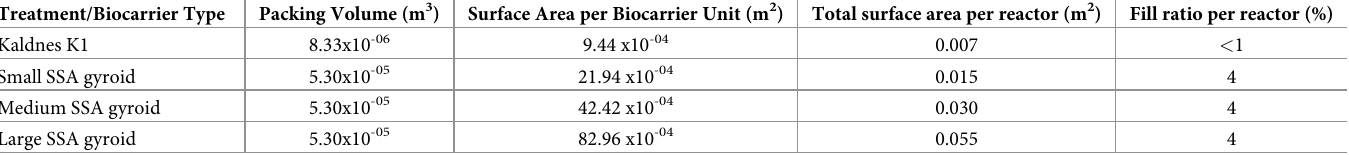
Table 4. Parameters for Experiment 3 with constant total number (count) of biocarriers (7 biocarriers each). Treatment/Biocarrier